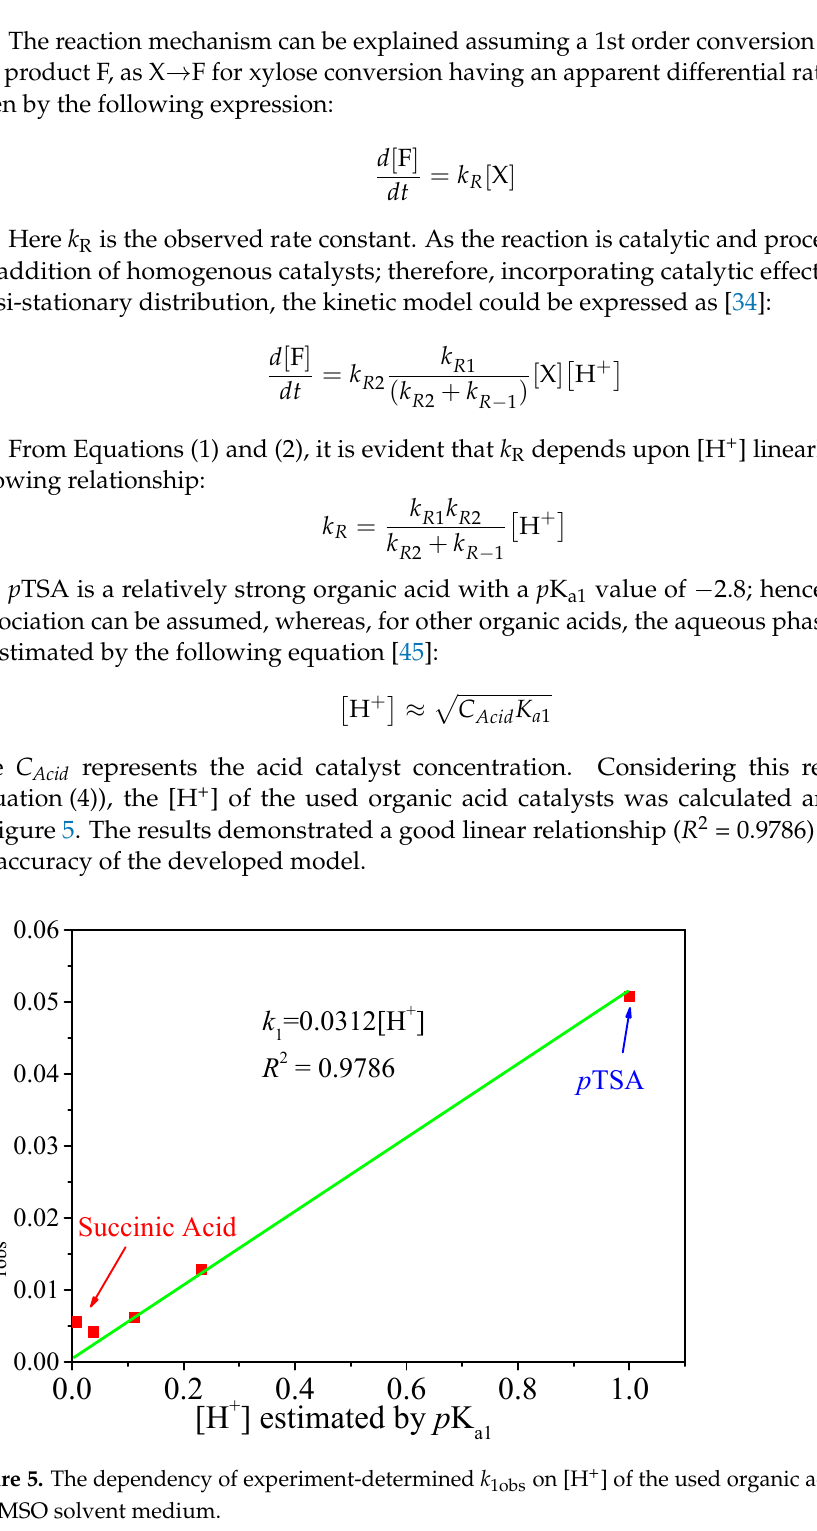
Figure 4. Kinetic plots of dehydration of xylose into furfural. Reaction conditions: 0.5 M xylose, 1.0 M organic acid, and 0.1 M CrCl 3 .6H 2 O catalysts in 50 mL DMSO at 120 °C for 5 h; ( A ) p TSA; ( B ) Oxalic acid; ( C ) Succinic acid; ( D ) Malonic acid; ( E ) Maleic acid. Lines represent calculated data whereas symbols represent experimental values. X: xylose; FF: furfural; HUM; humin.